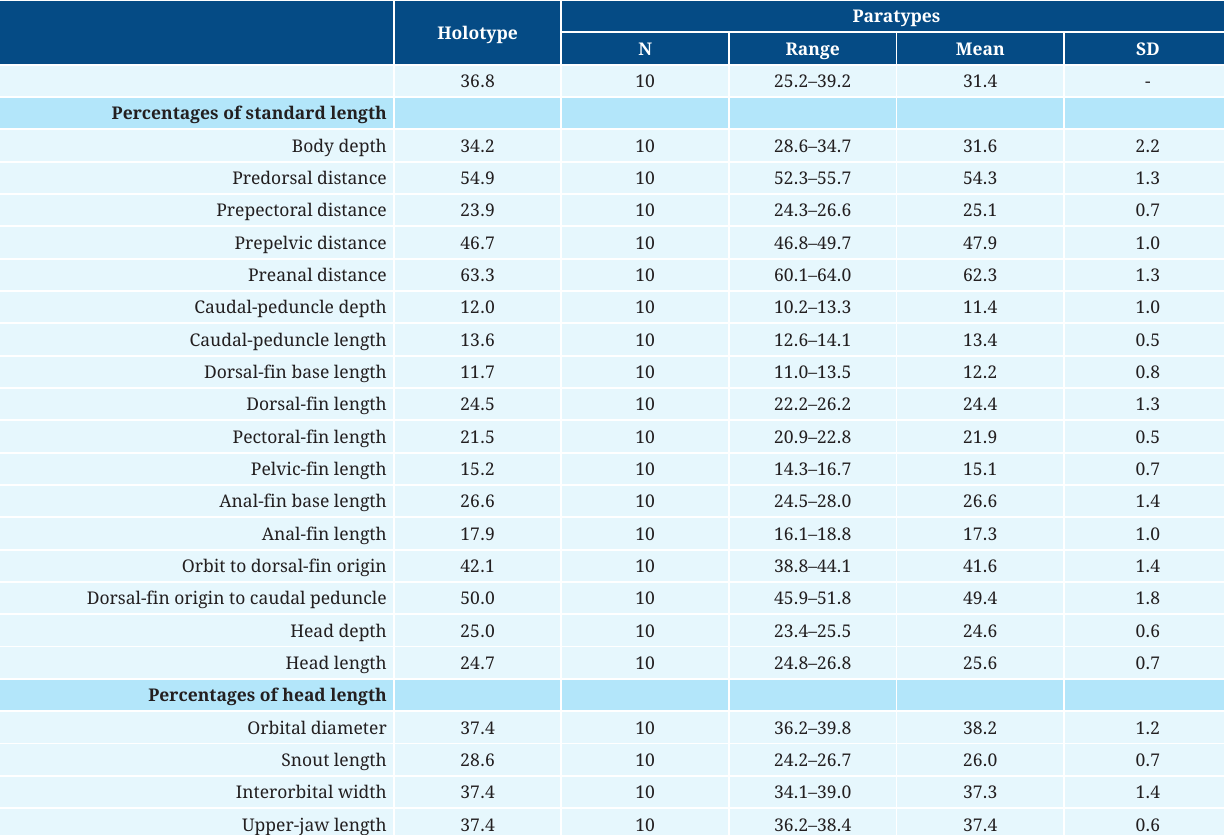
TABLE 1 | Morphometric data of Knodus rufford . SD = standard deviation; N = number of specimens.